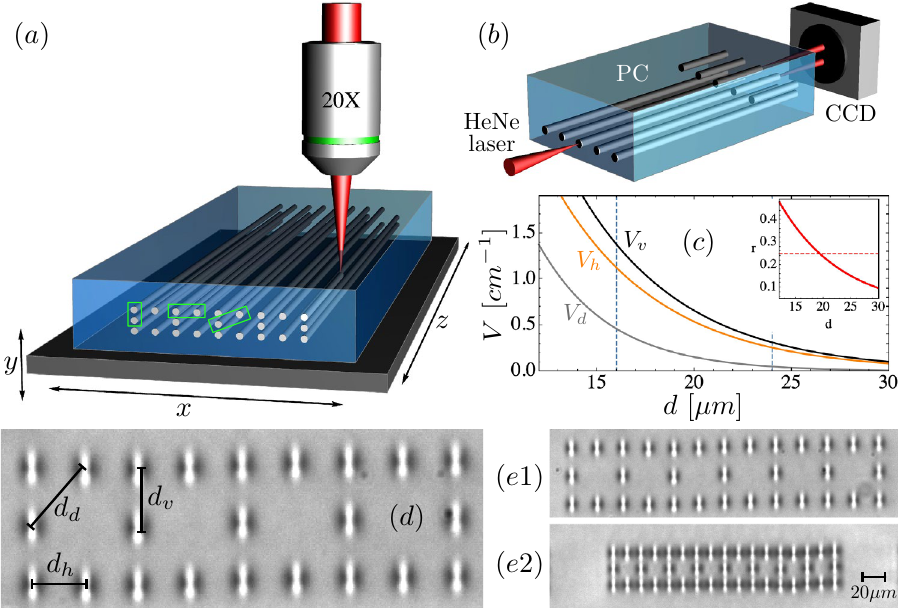
Figure 1. ( a ) Femtosecond waveguide writing setup. ( b ) Simplified characterization setup showing a focused HeNe laser beam at the input facet of a photonic chip (PC), and imaging onto a CCD camera. ( c ) Coupling V versus nominal distance d for vertical (black), horizontal (orange), and diagonal (gray) couplers. Vertical dashed lines are for d = 16 and 24 µ m. Inset: fractional ratio r versus d (horizontal dashed line corresponds to 25% ). ( d ) White light microscope zoom of a Lieb photonic ribbon. ( e1 ) and ( e2 ) Two ribbon examples with 33 and 43 waveguides for d v ( d h ) = 24 ( 22.9 ) µ m and 13.5 ( 12.4 ) µ m, respectively. This figure was drawn using